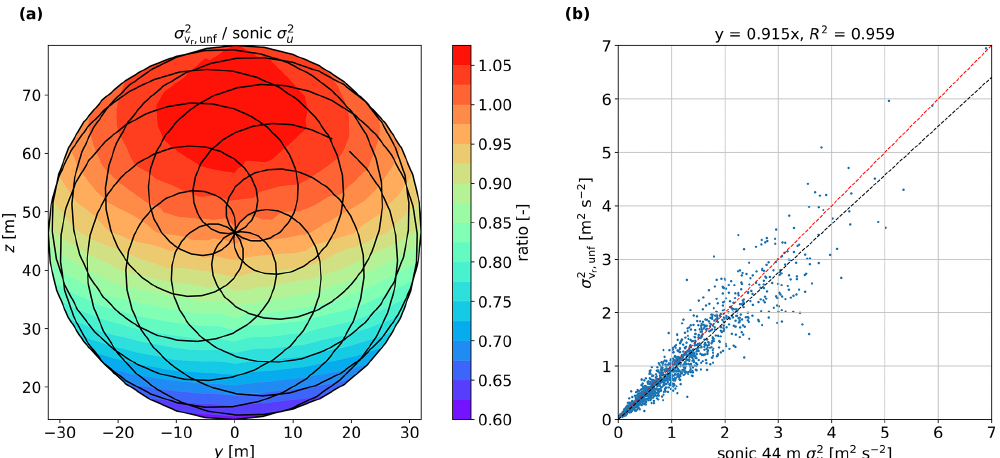
Figure 11. (a) Ratio of the unfiltered radial velocity variance to the u -velocity variance of the sonic anemometer from the simulations (30 turbulence boxes are used). (b) Comparison between the unfiltered radial velocity variance at the central grid cell ( y = 0m, z = 48m) and the u variance of the sonic anemometer at 44m from the measurements. Features regarding the red and black dashed lines as in Fig. 9.